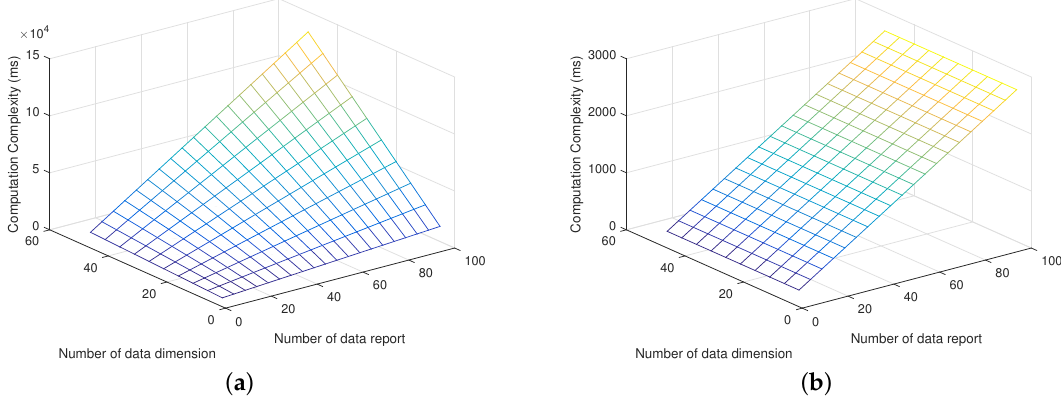
Figure 4. Computation complexity of data server. ( a ) Computation complexity of the data server with the traditional scheme; ( b ) Computation complexity of the data server with the proposed